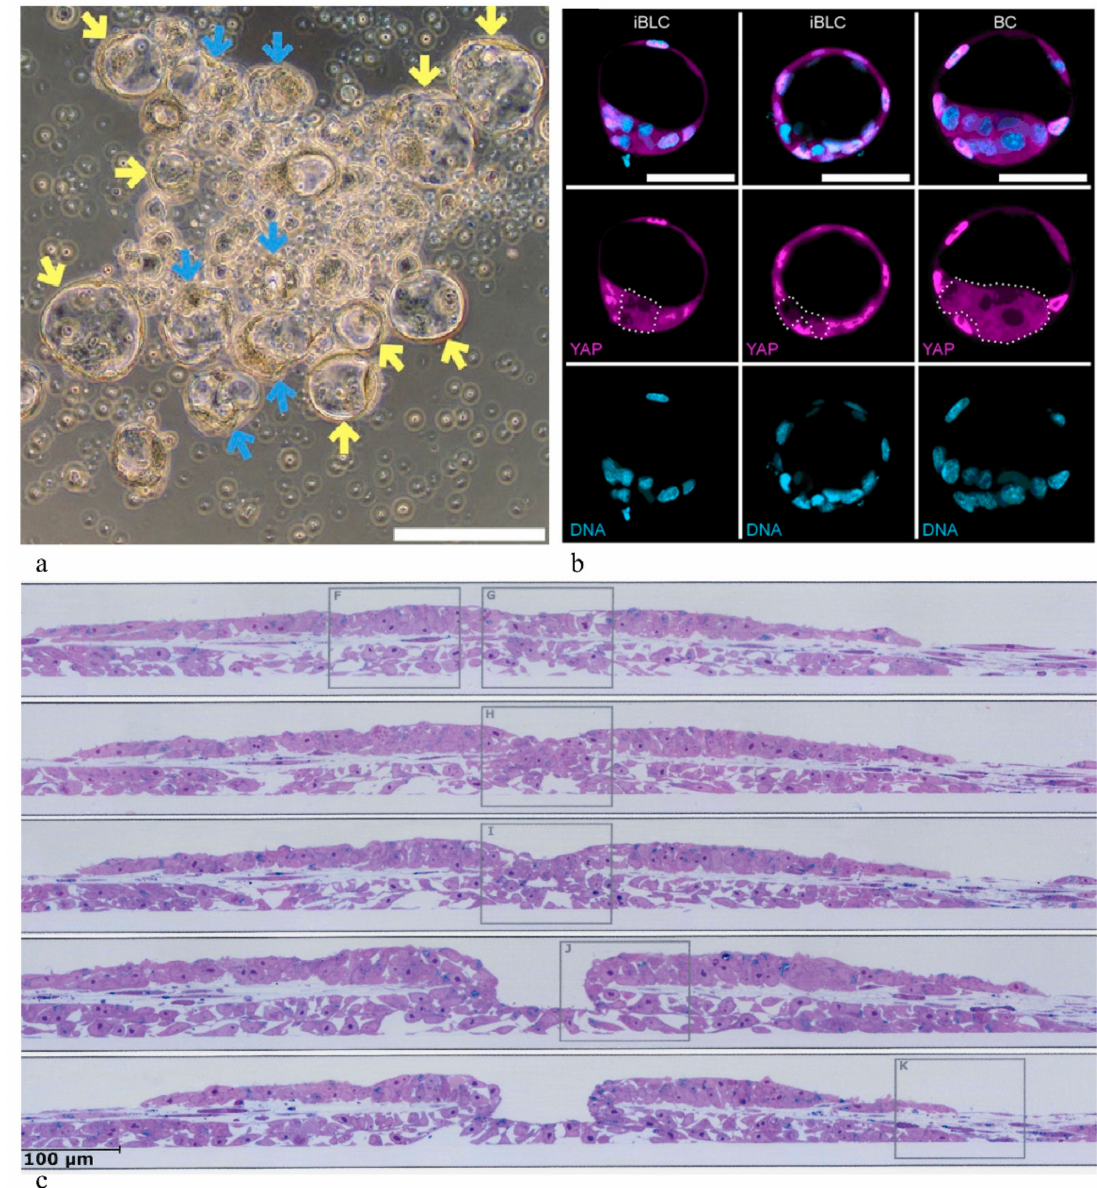
Figure 1. Embryoid structures autonomously developing in stem cell cultures. ( a , b ) Blastocyst-like cysts sprouting from a colony of mouse PPSCs: ( a ) morphology; ( b ) composing cell types of induced blastocyst-like cysts (iBLCs) in comparison with a blastocyst (BC). Embryoblast cells: magenta (YAP); DNA: light blue (from Kime et al. [71], with permission). ( c ) Embryonic disc-like colony formed spontaneously in rhesus monkey PPSC culture, showing a crater mimicking gastrulation- like cell ingression (serial sections) (from [73], with